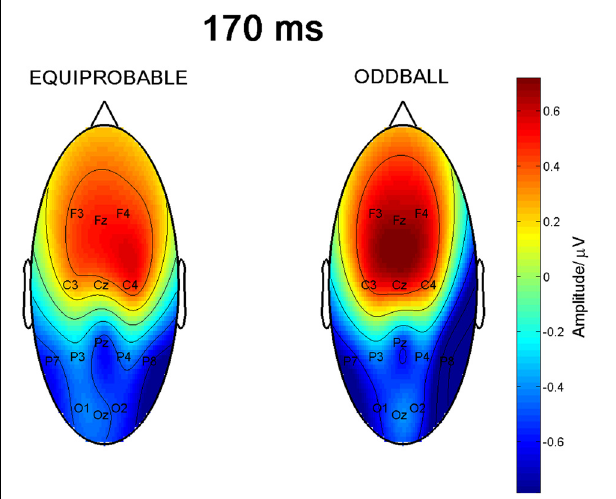
FIGURE 9 | Scalp potential maps of the 170-ms component back-projected to the electrodes. Map for the equiprobable condition group on left and map for the oddball condition group on right.